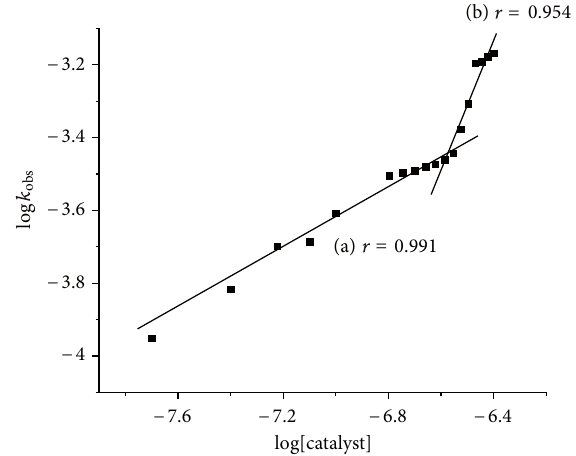
F 3: Plot of versus log[catalyst] showing the effect obs of catalyst concentration (a) 2–20 log𝑘𝑘